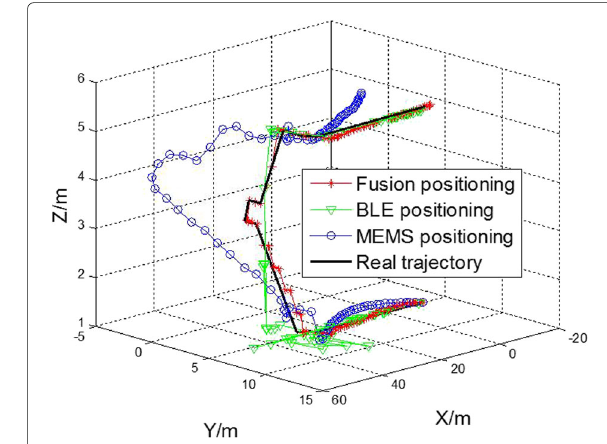
Fig. 26 Results in 3D view